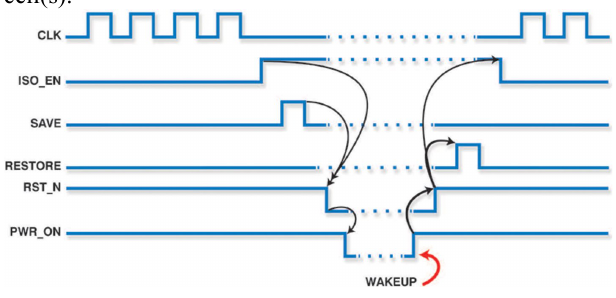
Figure 1. Power gating & power un-gating